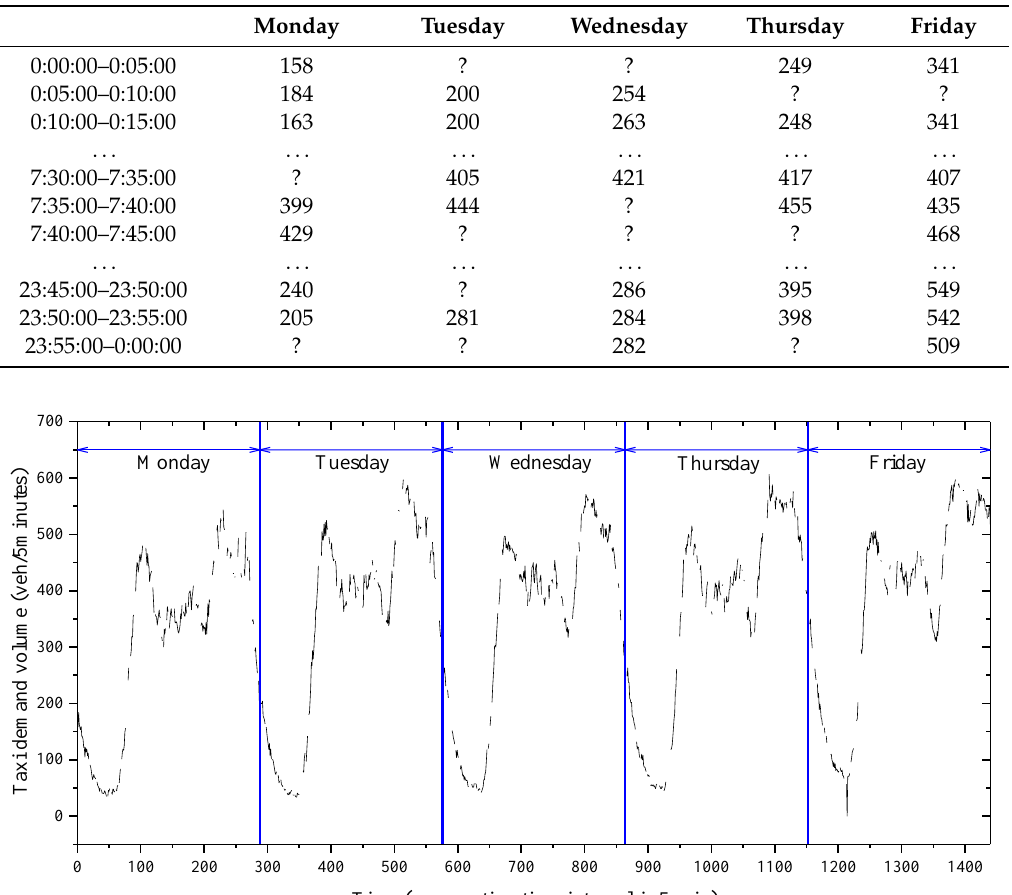
Table 2. Taxi demand volume on weekdays. The “question marks” in Table 2 represent the missing values.